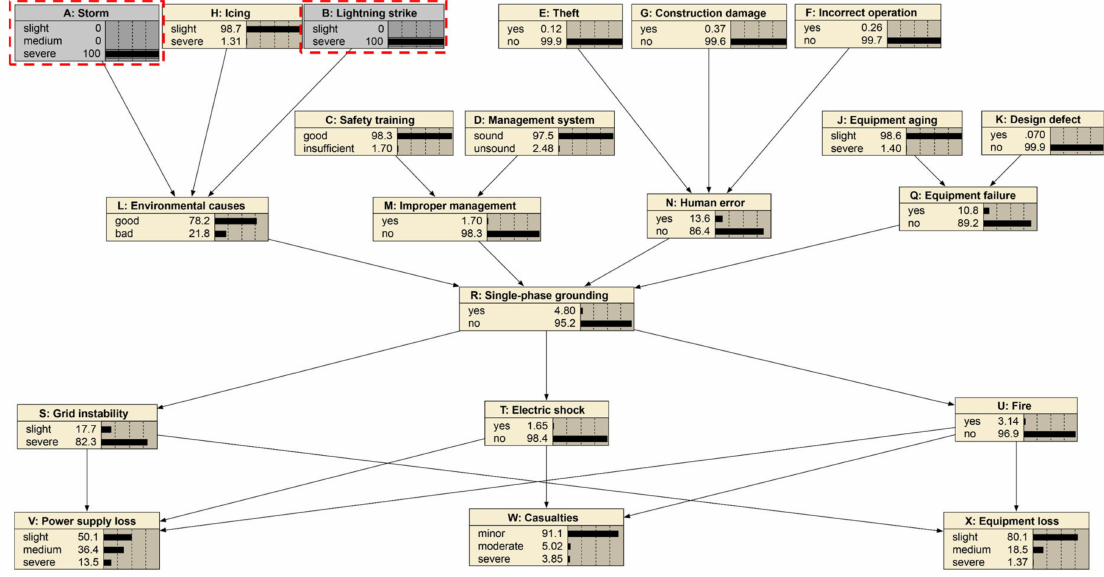
Figure 6. Case study for severe storm and severe strike.